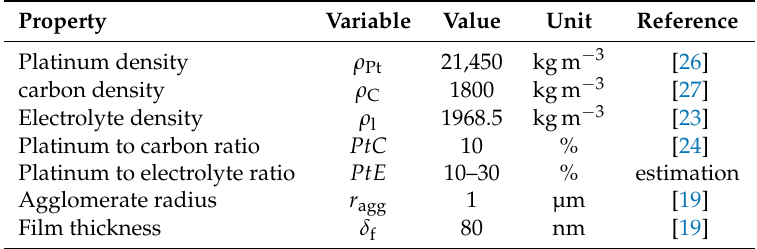
Table 2. Material properties and composition information of the